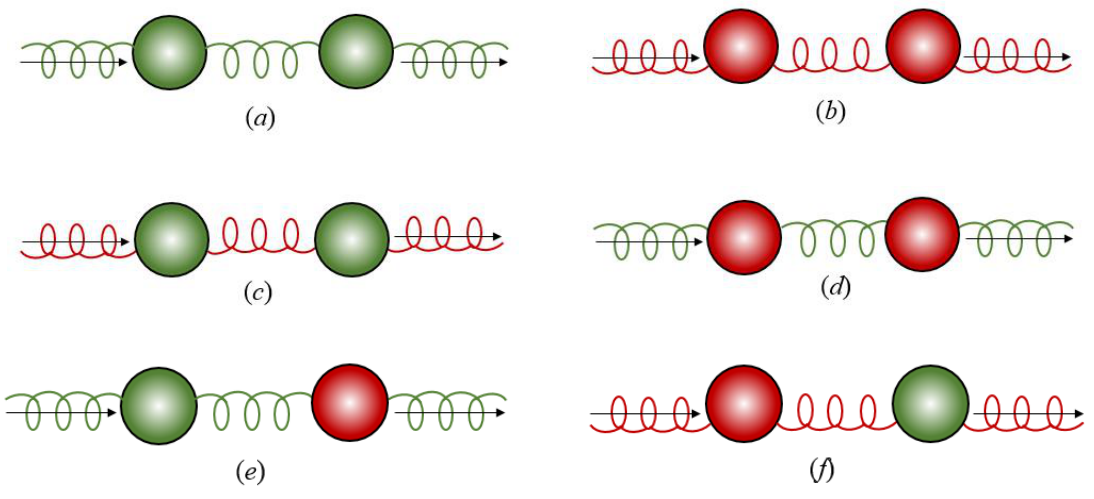
Figure 2. Illustration of the equivalences ( a ≡ b , c ≡ d ), and non-equivalences ( a , b ≠ c , d ), between the discriminatory optical binding forces between chiral particles of different handedness (depicted by red and green spheres) irradiated by circularly polarized light of either handedness (right- and left-handed forms shown with opposite twist). For cases e , f , where the two species are enantiomers, the discriminatory force vanishes: the pair effectively represents a system that is achiral, and the optical binding force is accordingly independent of the handedness of